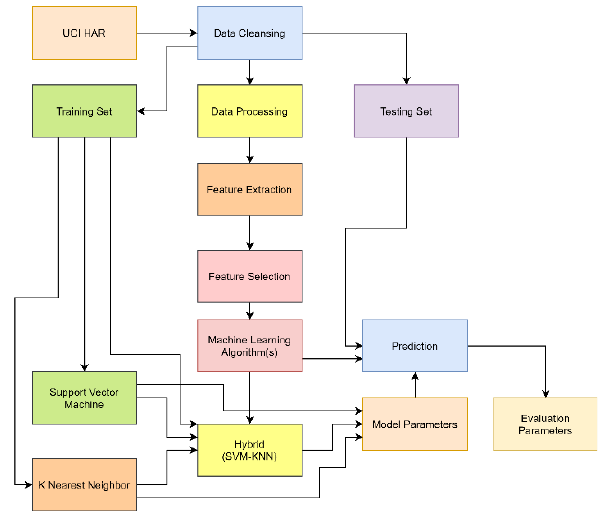
Figure 2. Proposed Methodology for Machine